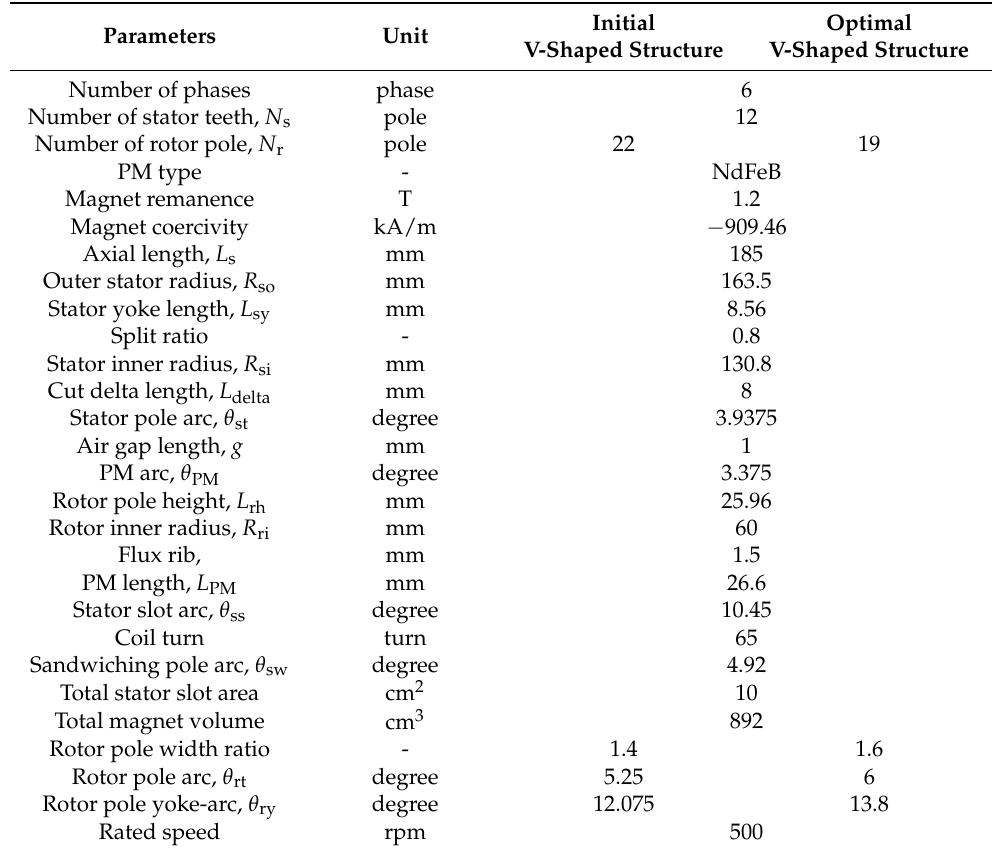
Initial Optimal V-Shaped Structure V-Shaped Structure